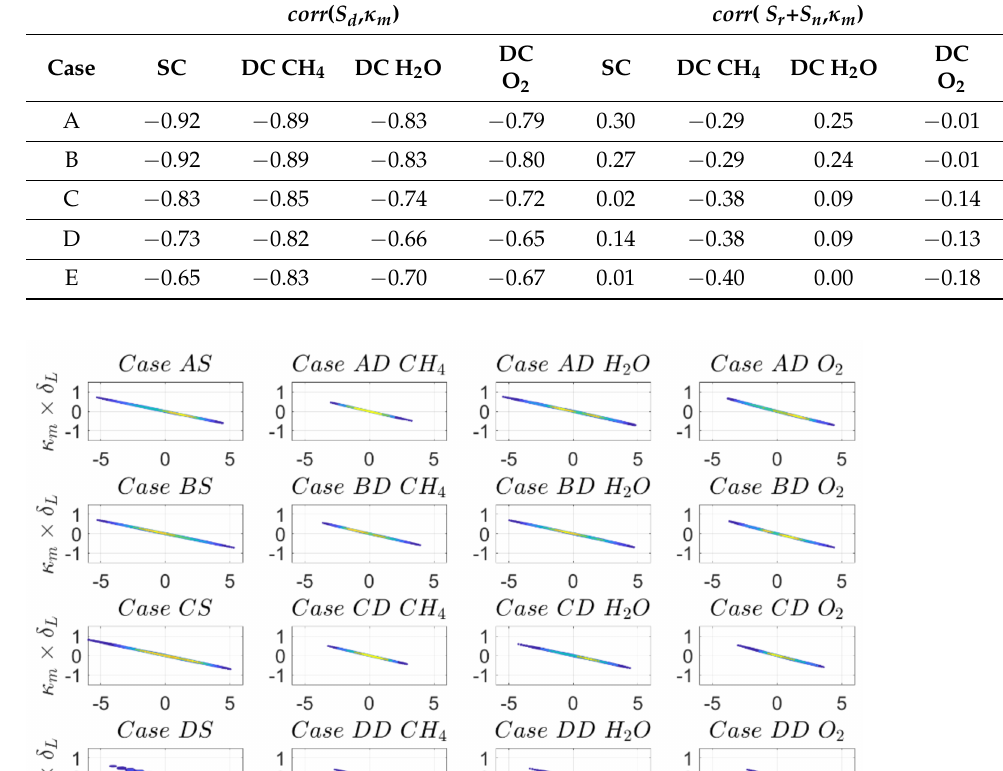
Table 10. Correlation coefficients between S d and ( S r + S n ) with κ m for the c = 0.8 isosurface value for all cases.